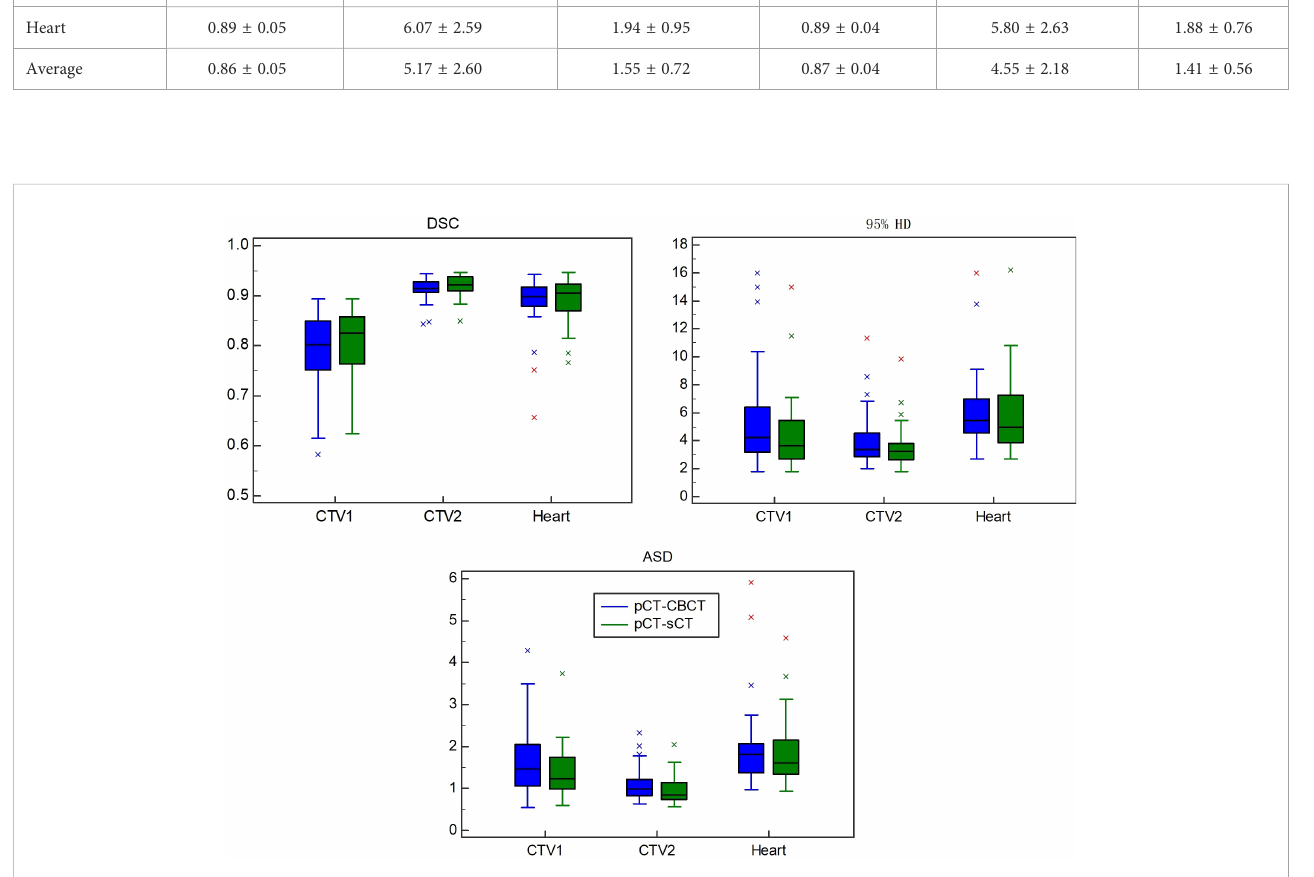
FIGURE 6 The results of the Dice similarity coef fi cient (DSC), 95 percent Hausdorff distance (HD95), and average surface distance (ASD) on the various techniques.